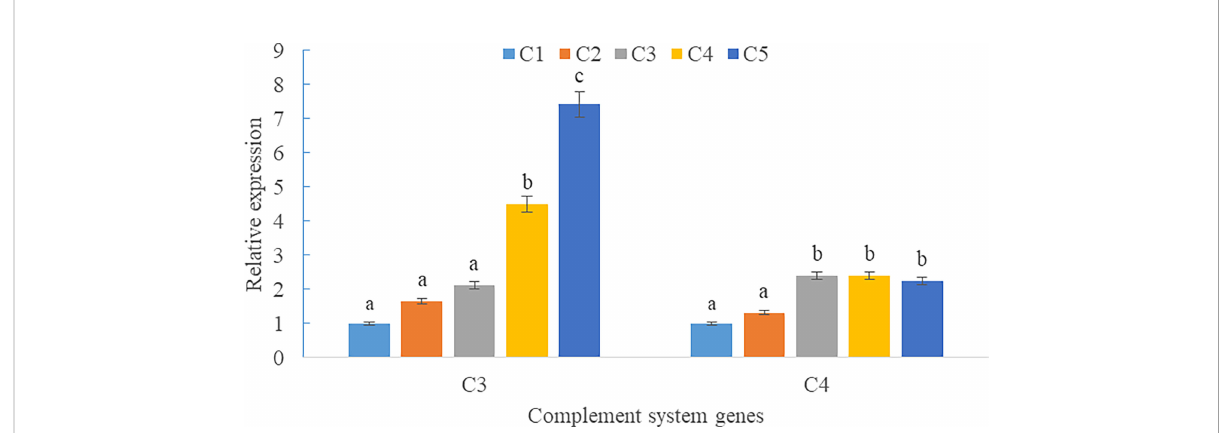
FIGURE 5 Effects of fi shmeal replacement by cottonseed protein concentrate on the mRNA expression levels of complement system genes c3 and c4 in intestine of rainbow trout (Mean ± S.E.). Different letters on the bar chart indicate signi fi cant difference ( P <